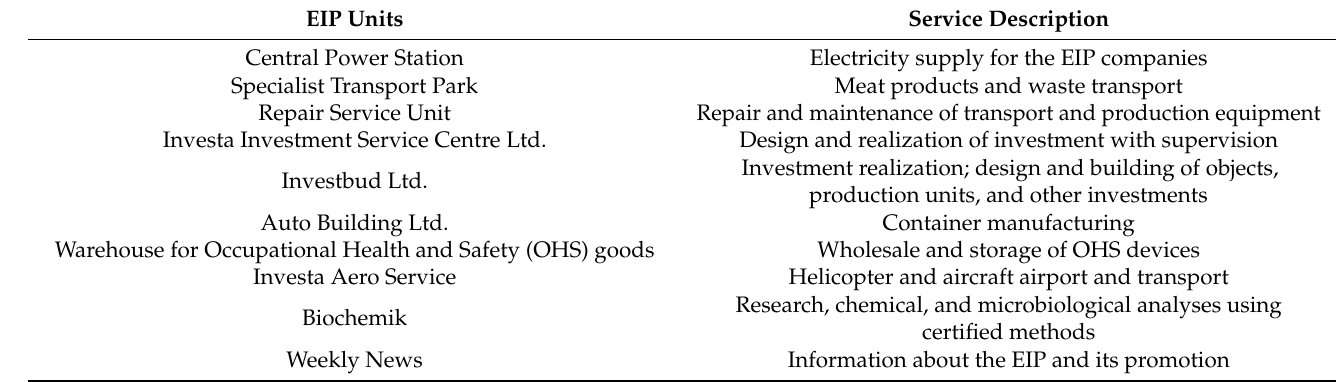
Table 2. Companies providing services in the ´Smiłowo EIP also for all the Farmutil